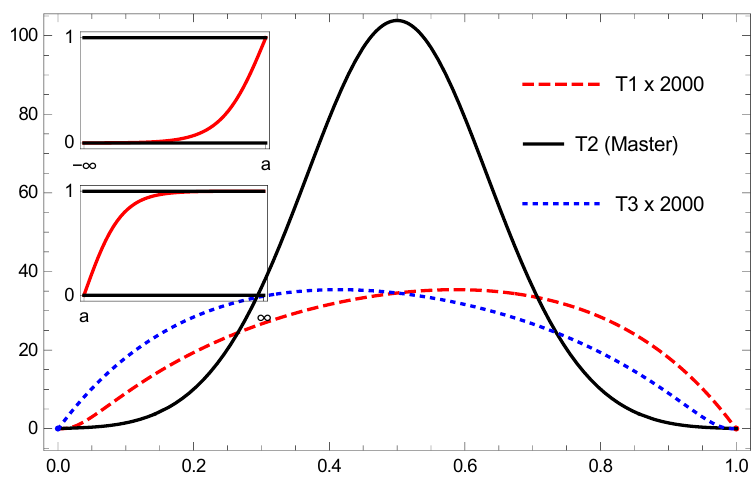
Figure 6: Boltzmann factor exp ( − Re ( S )) vs. flow parameter τ on the contributing thimbles in the U(1) one link model, where thimbles end in poles. Here it is necessary to transform integration ranges to maximize overlap. We chose to map all integration ranges to [ 0,1 ] , which can be done by a linear transformation for a thimble on [ a , b ] or appropriate hyperbolic tangent transformations for intervals [ −∞ , a ] or [ a , ∞ ] , see inlays and (23) and (24) for the latter two transformations (we chose the free parameter of the transformation as ξ = 1.5). For details see App. B. This choice is not unique. Note that the curves have been rescaled for better